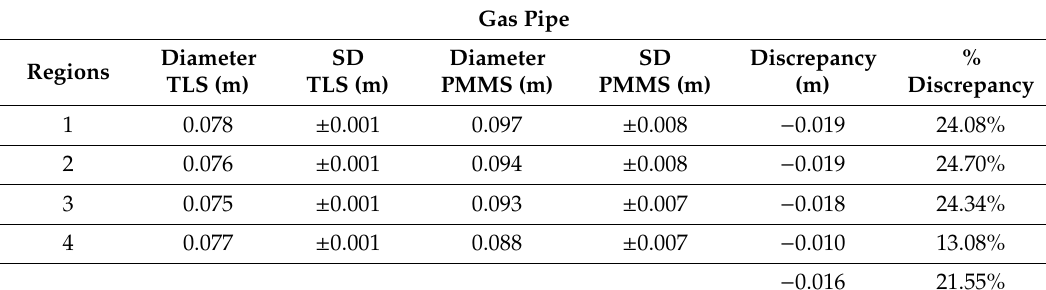
Table 3. Diameters discrepancies and standard deviations (SD) obtained from the RANSAC cylinder fitting of the pipes: gas pipe regions (Figure 7).